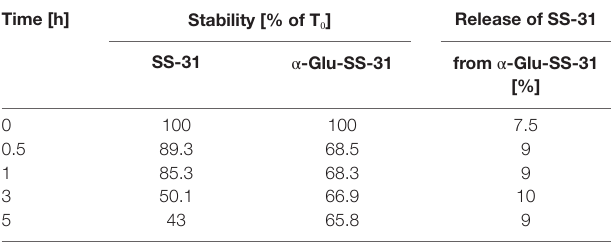
TABLE 2 | Stability of SS-31 and α -Glu-SS-31 in mouse plasma.